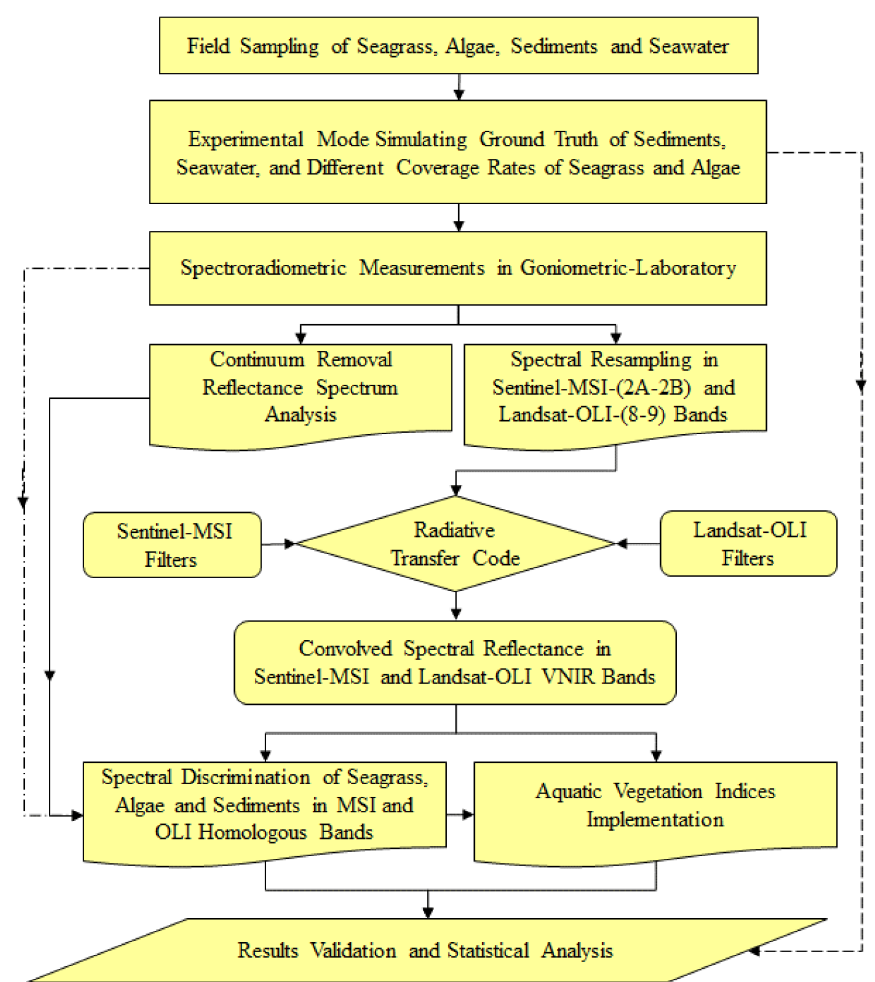
Figure 2. Methodology